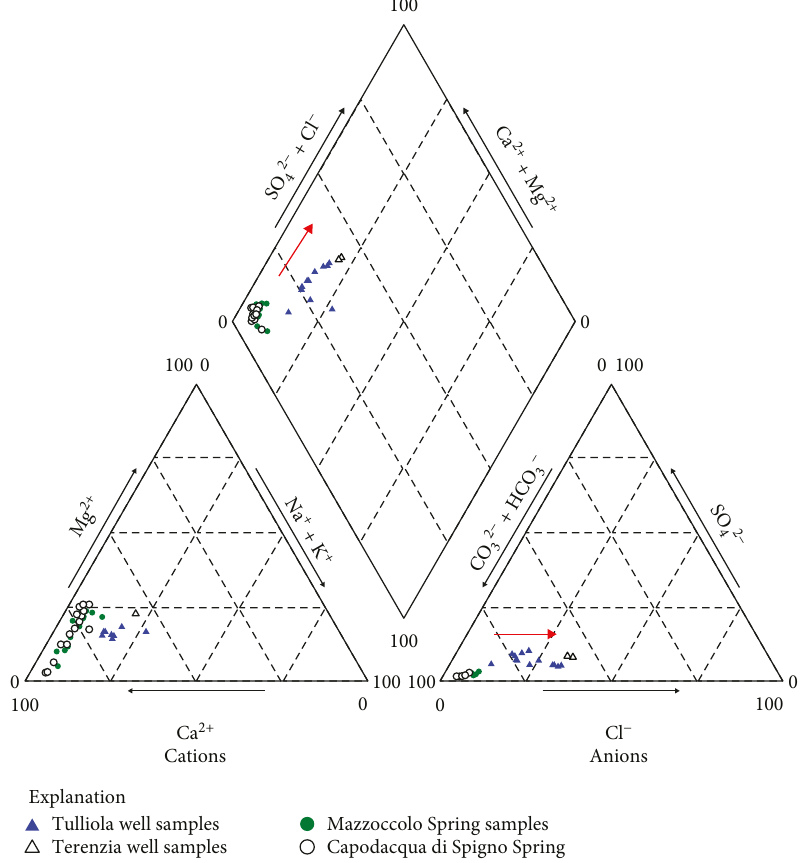
Figure 7: Piper trilinear diagram showing hydrogeochemical facies of the